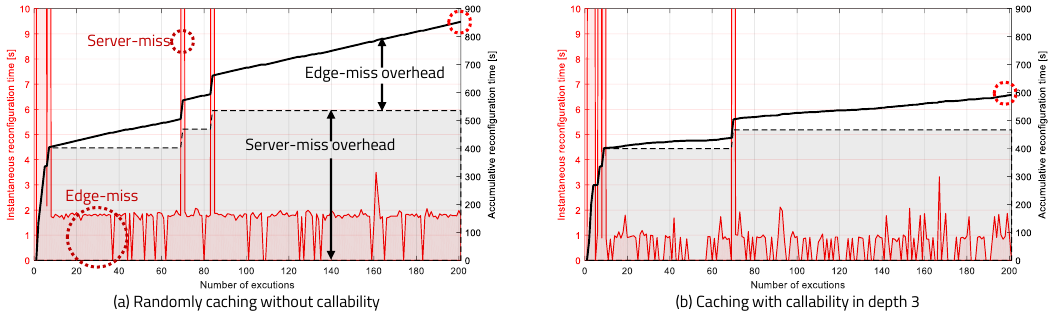
Figure 19. Instantaneous and accumulative reconfiguration